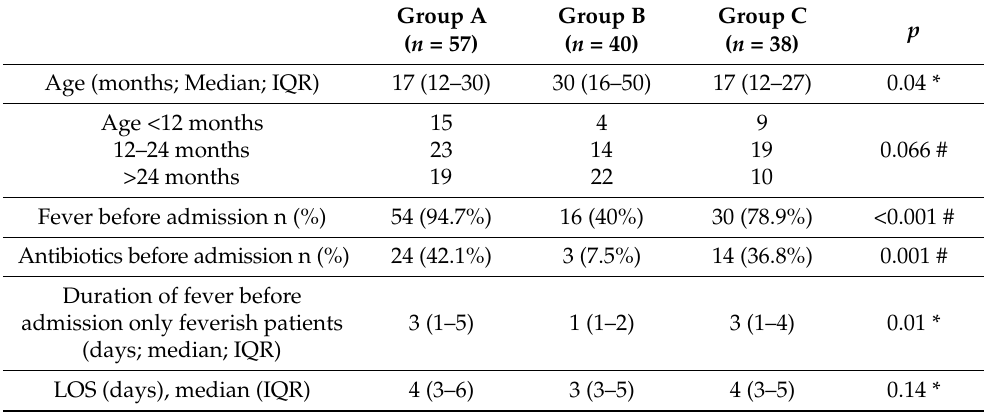
Table 1. Demographic and clinical characteristics of patients with adenoviral infection.